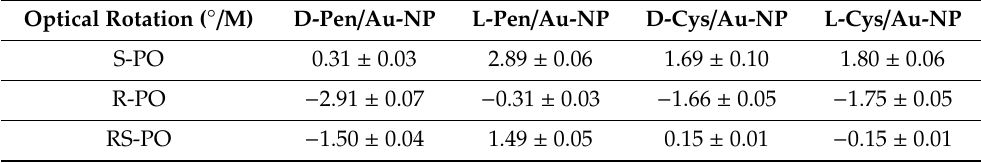
Table 1. Specific optical rotation during addition of R-, S- and RS-PO to solutions of Au-NPs that have been chirally modified with D- or L-Pen, or D- or